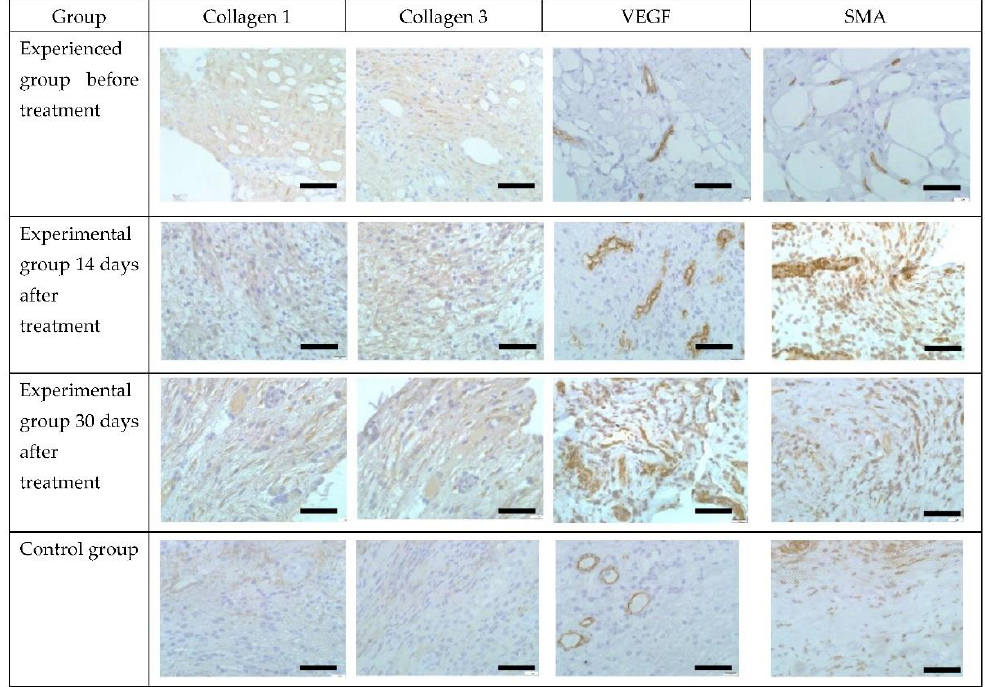
Figure 9. Immunohistochemical characterization of the content of collagen type 1 and collagen type 3, VEGF, and SMA+ myofibroblasts in the DU before and after treatment with alternating current electrical stimulation using a high-frequency generator. Legend: 1 — experimental group before treatment, 2 — experimental group 14 days after treatment, 3 — experimental group 30 days after treatment, 4 — control group. Immunoperoxidase reaction with DAB. The scale bar is 100 µm.